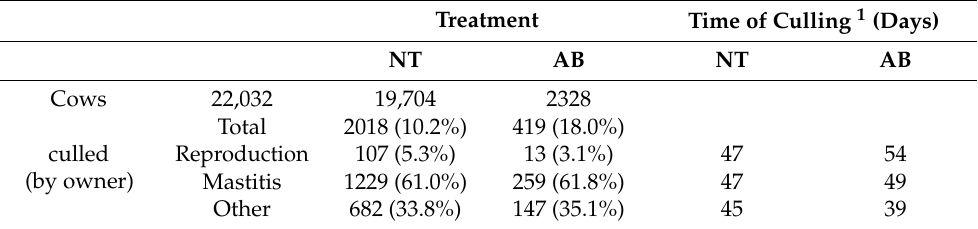
Table 5. Number and percentage of culled cows for 90 days from first somatic cell count (SCC) elevation, cause and distribution of time of culling for SCC-cutoff level ≥ 1000 × 10 3 cells/mL (CL5), separately for non-treated (NT) and antibiotic-treated (AB) cows. Treatment Time of Culling 1